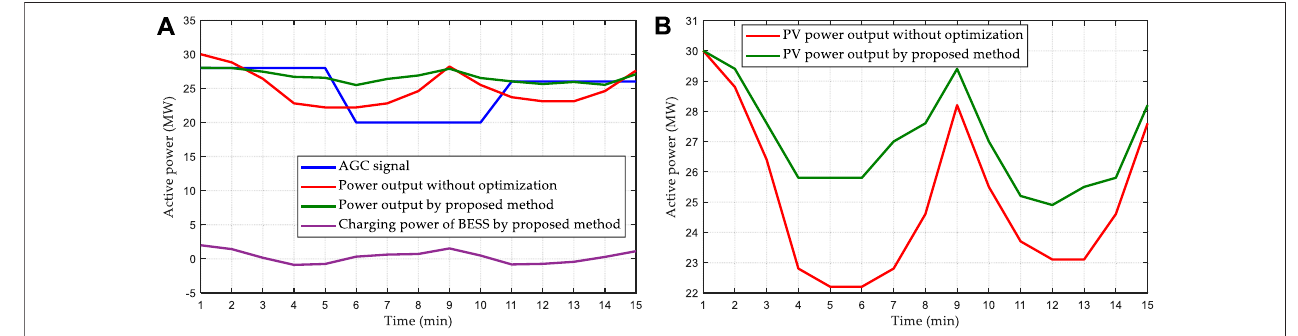
FIGURE 11 | Optimal power outputs of the proposed method and that without optimization on the varying AGC signals.